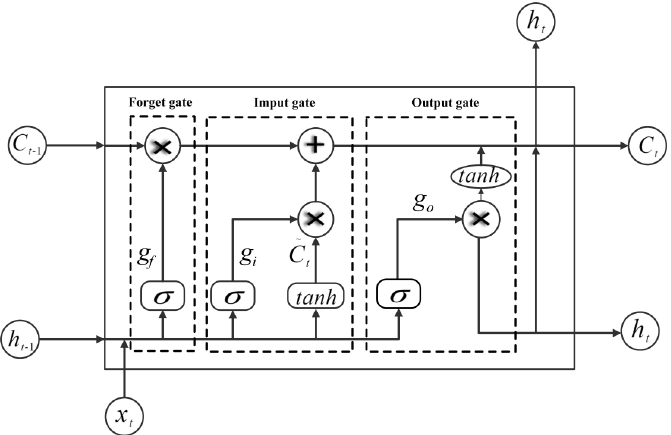
Figure 2. LSTM structure.